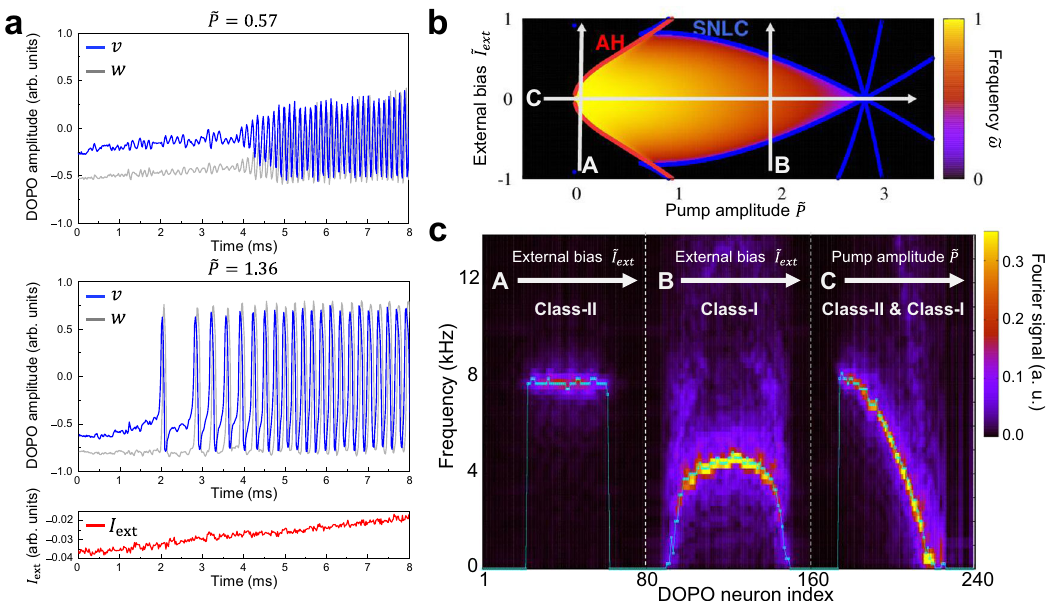
Fig. 2 Class-I and II spiking modes of a DOPO neuron. a Time evolutions of v - and w -DOPOs (blue and gray lines) with constant pump amplitudes ( e P = 0.57 and 1.36) and an external bias increased linearly with time. b Phase diagram of the DOPO neuron in the parameter space of P and I ext . The color map represents spiking frequencies calculated by numerical simulations. Red and blue dots obtained by linear stability analysis represent points where the Andronov – Hopf (AH) bifurcation and saddle-node bifurcation on a limit cycle (SNLC) occur, so they characterize class-II and class-I neurons, respectively. c Experimental results of tomographic measurement of spiking frequencies along lines A, B, and C in ( b ). The color map represents Fourier signals of time evolutions of DOPO amplitudes. Cyan points are fi ring rates estimated by adding up the number of spikes.